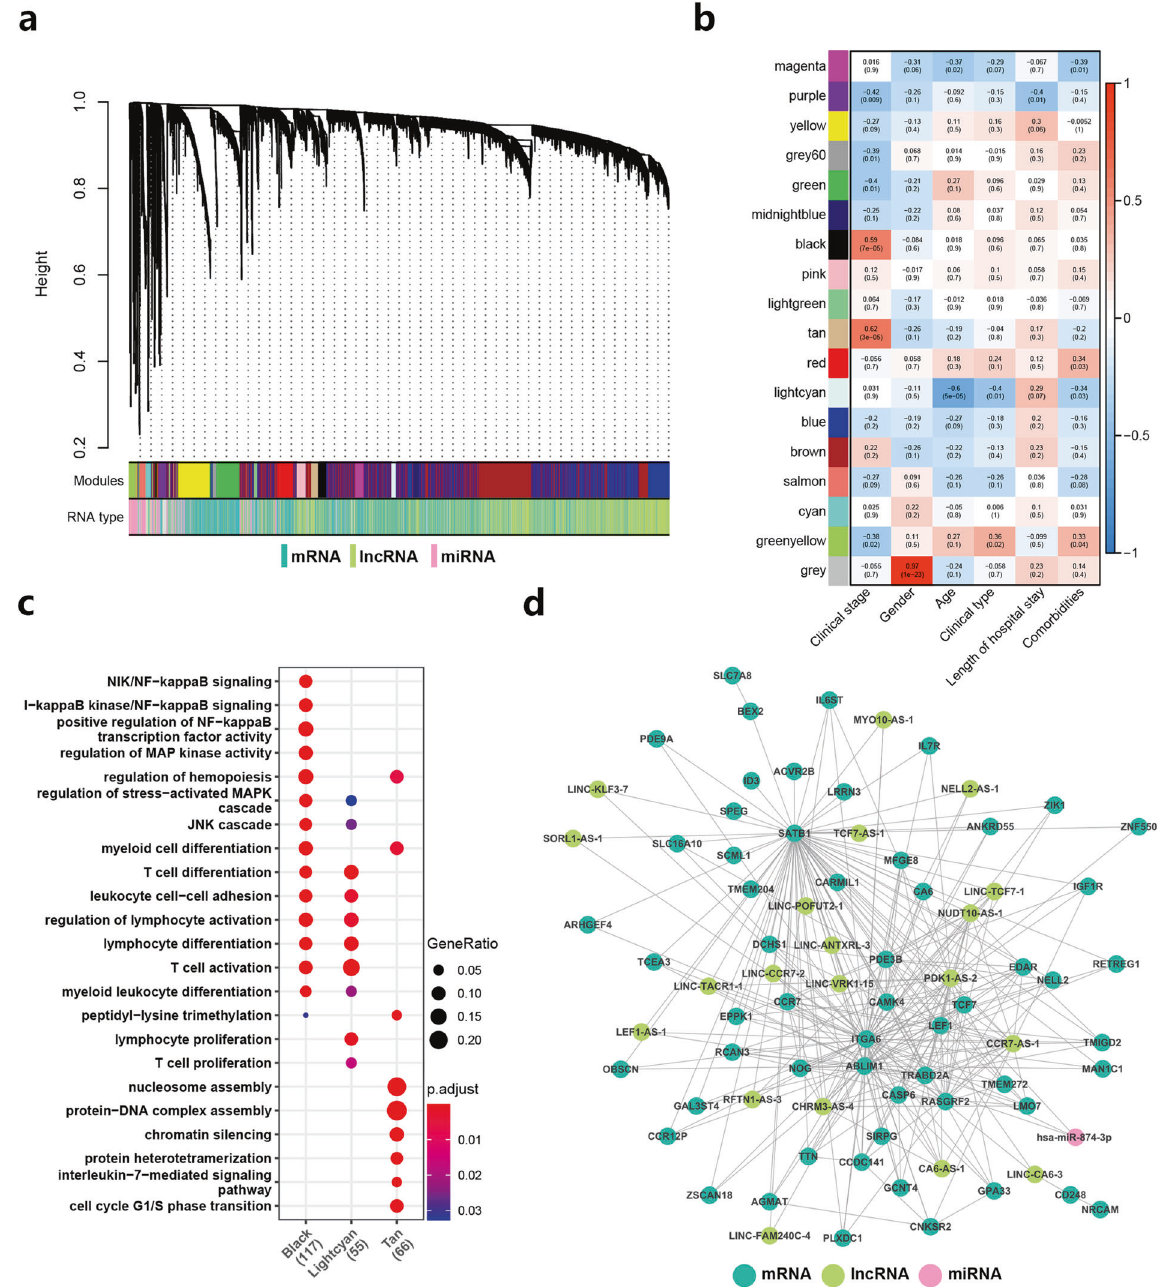
Fig. 6 Weighted correlation network analysis (WGCNA) showed the impact of multiple clinical features on the transcriptomic pro fi ling of peripheral blood cells from patients with COVID-19 during the recovery. a A hierarchical clustering tree showing all modules based on top 8000 most variably expressed mRNAs/lncRNAs and top 600 most variably expressed miRNAs in all samples. b A matrix plot showing the correlations between modules ( Y axis) and clinical factors ( X axis). The color and the number outside the brackets of a square indicate the Pearson ’ s correlation r value between a module and the corresponding clinical factor, and the number inside the brackets indicates the Pearson ’ s correlation p value. c A bubble plot showing the GO enrichment analysis results of the black, light cyan and tan modules. The numbers in brackets on the X axis indicate the total number of signi fi cantly enriched genes in each module. The bubble size indicates the gene enrichment ratio (GeneRatio) of a GO term, with color referring to the FDR value (p.adjust) of enrichment analysis. d A correlation network showing the co-expression pattern between genes and non-coding RNAs in the light cyan module patients with moderate and severe COVID-19, as re fl ected by the (~20 – 40 days), and there are no signi fi cant differences between decreased level of T cells, including Th1, Treg, and CD8 + patients with varying clinical features. The fast decline of humoral immunity against COVID-19 will pose challenges to vaccination, T cells. 1,39,40 In addition, neutrophils increased and monocytes and the detailed mechanism underlying this awaits further study. decreased in COVID-19 patients. 39,41 These abnormalities may be A large number of studies have shown that SARS-CoV-2 reversed in some immune cells after recovery. For example, infection can cause a more pronounced lymphocytopenia in Sekine, et al. 42 found that the SARS-CoV-2 speci fi c T cells in acute Signal Transduction and Targeted Therapy (2020)